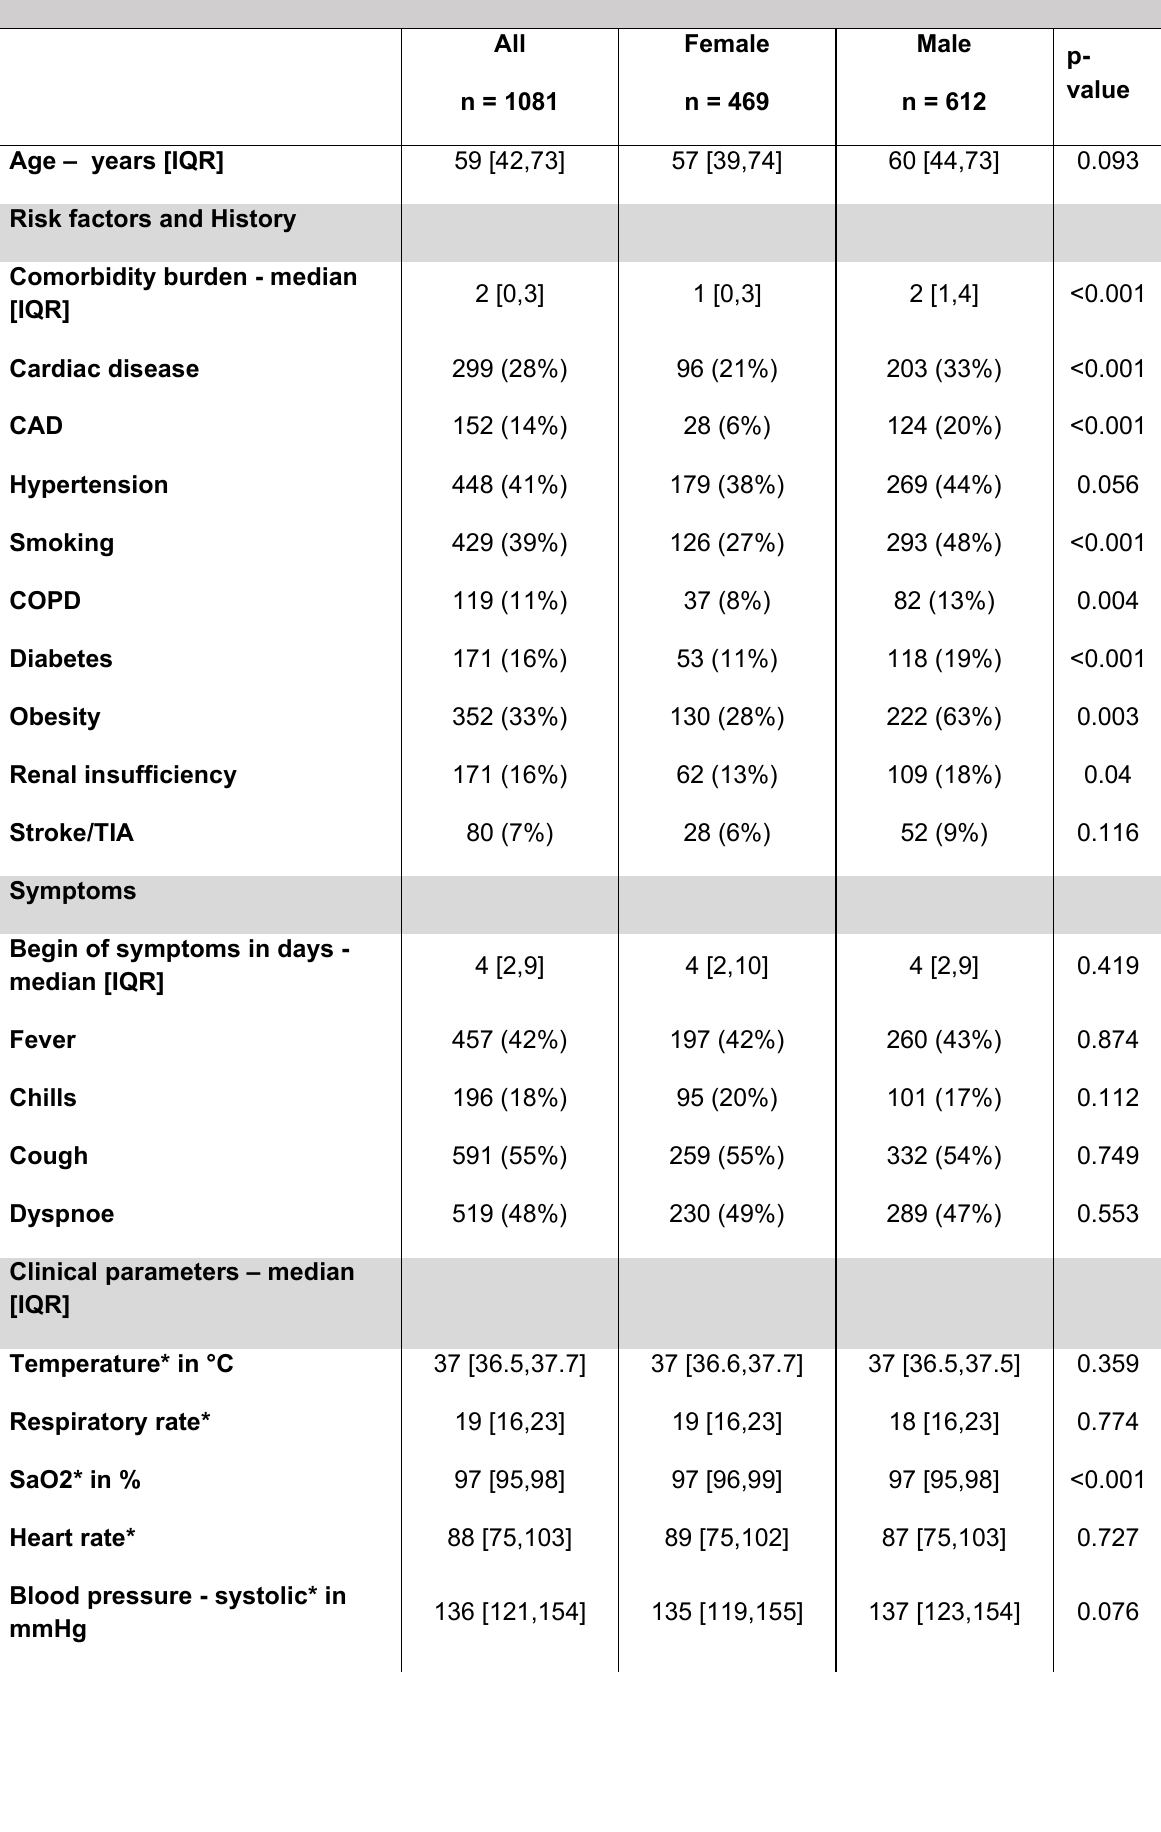
Table S3: Clinical characteristics of the unselected study population